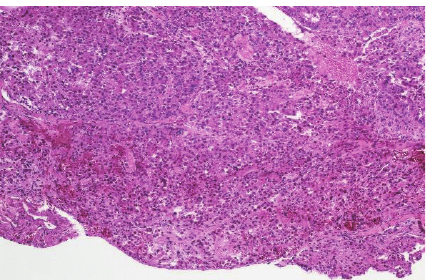
Figure5:Lowmagnificationfieldofthetumorshowinghepatocytes with trabecular pattern of varying thickness separated by sinusoids, features consistent with HCC.